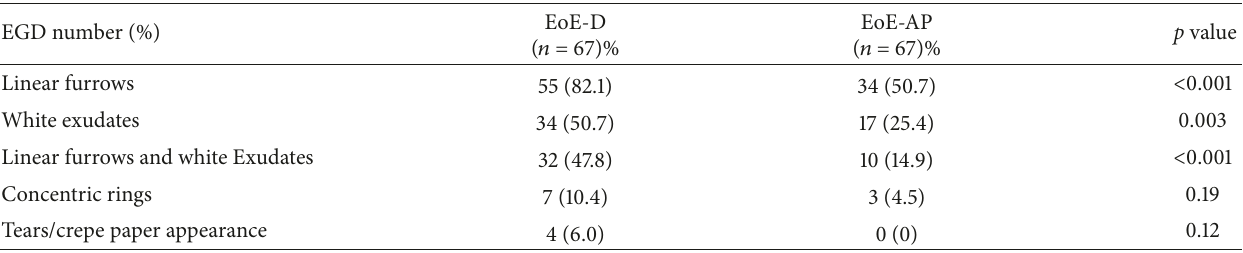
Table 2: Endoscopic findings of patients with EoE.